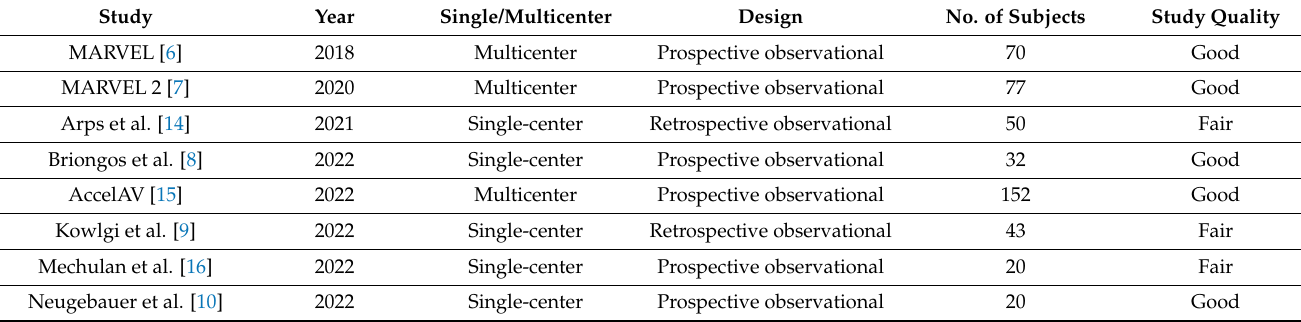
Table 1. Characteristics of the studies included in the meta-analysis.